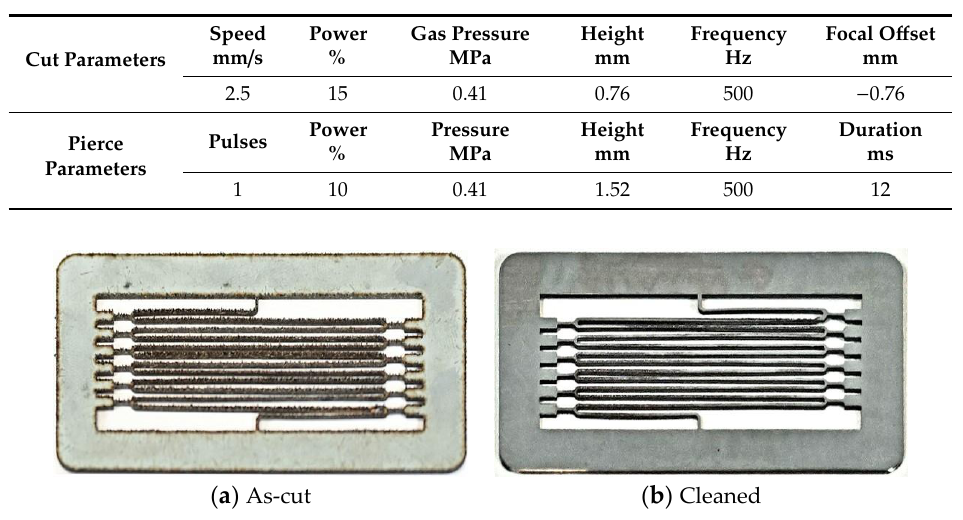
Figure 8. Stainless steel flexure – FabLight Fiber Laser (CBA).